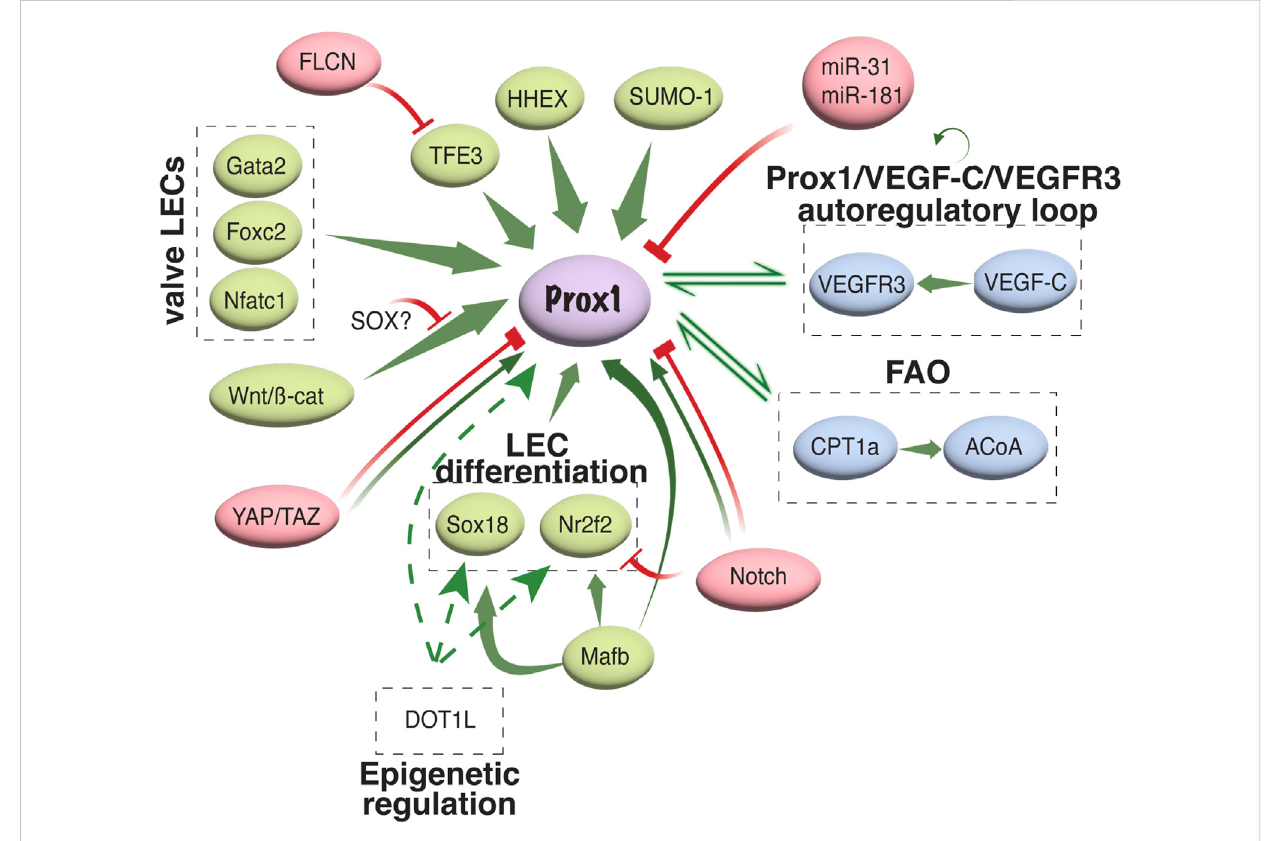
FIGURE 3 Transcriptional and epigenetic regulation of Prox1 in the vascular system. Schematic representation of different activators/repressors of Prox1 expression in the vascular system is shown. FAO, fatty acid oxidation; ACoA, acetyl coenzyme A.